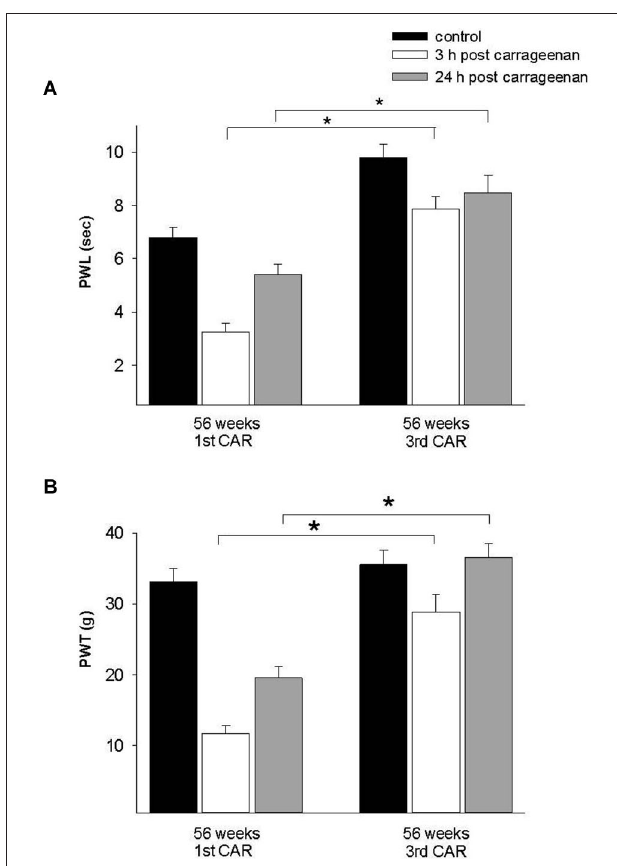
FIGURE 7 | Effect of repeated inflammation on nociceptive responses in old rats. (A) Differences in the thermonociceptive and (B) mechanociceptive response in 56-week old rats which had a CAR injection for a first or third time. The first application caused a significant decrease in both responses 3 h post-injection (white bars), whereas with a third application the latency to withdrawal is increased in both tests ( F = 28.258, p = 0.001; F = 31.965, p = 0.001). * p = 0.001. Data are expressed as mean ±